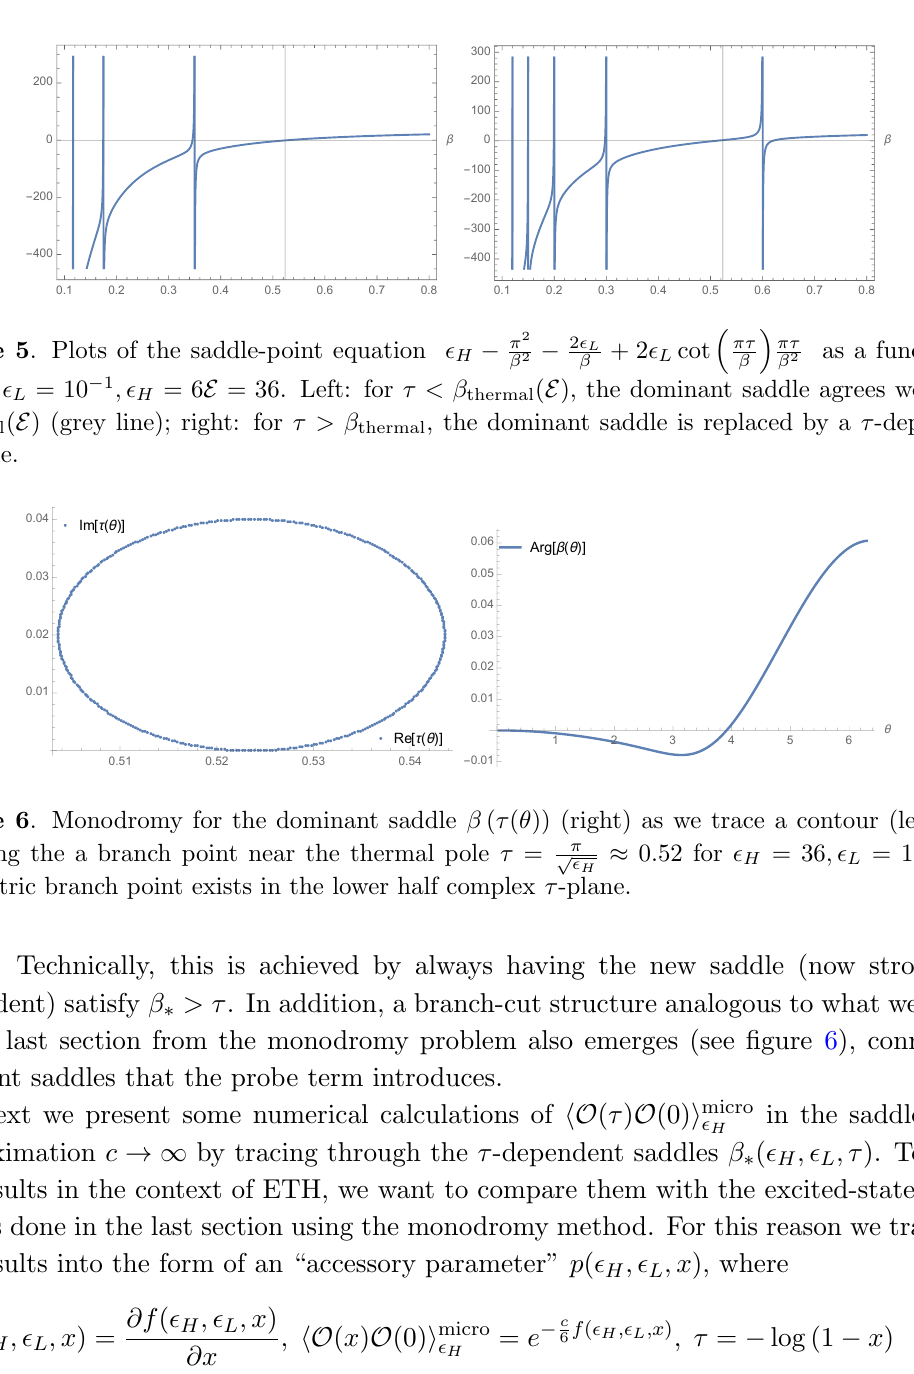
(cid:16) (cid:17) 2 (cid:15) L (cid:25) 2 (cid:25)(cid:28) (cid:25)(cid:28) + 2 (cid:15) L cot as a function of H (cid:0) (cid:12) 2 (cid:0) (cid:12) (cid:12) (cid:12) 2 ), the dominant saddle agrees well with E